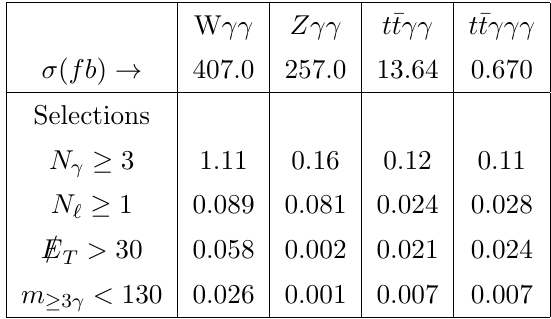
Table 5 . Background cross section after each set of cuts normalizing it by acceptance e(cid:14)ciencies. Simulating signal and background processes implementing all selection cuts as de- scribed above, we estimate the signal signi(cid:12)cance for few integrated luminosity options, L = 100 ; 300 ; 1000 fb (cid:0) 1 . Before presenting the signal sensitivity, we discuss the e(cid:11)ect of selection cuts showing event summary for both the signal in tables 3, 4 and backgrounds in 5. These tables show the cross sections times e(cid:14)ciency after each set of selection cuts as shown in the 1st column. The total production cross sections ( (cid:27) (fb)) are shown for each of the processes. Three benchmark choices of m = 10 GeV, 30 GeV and 60 GeV are A 1